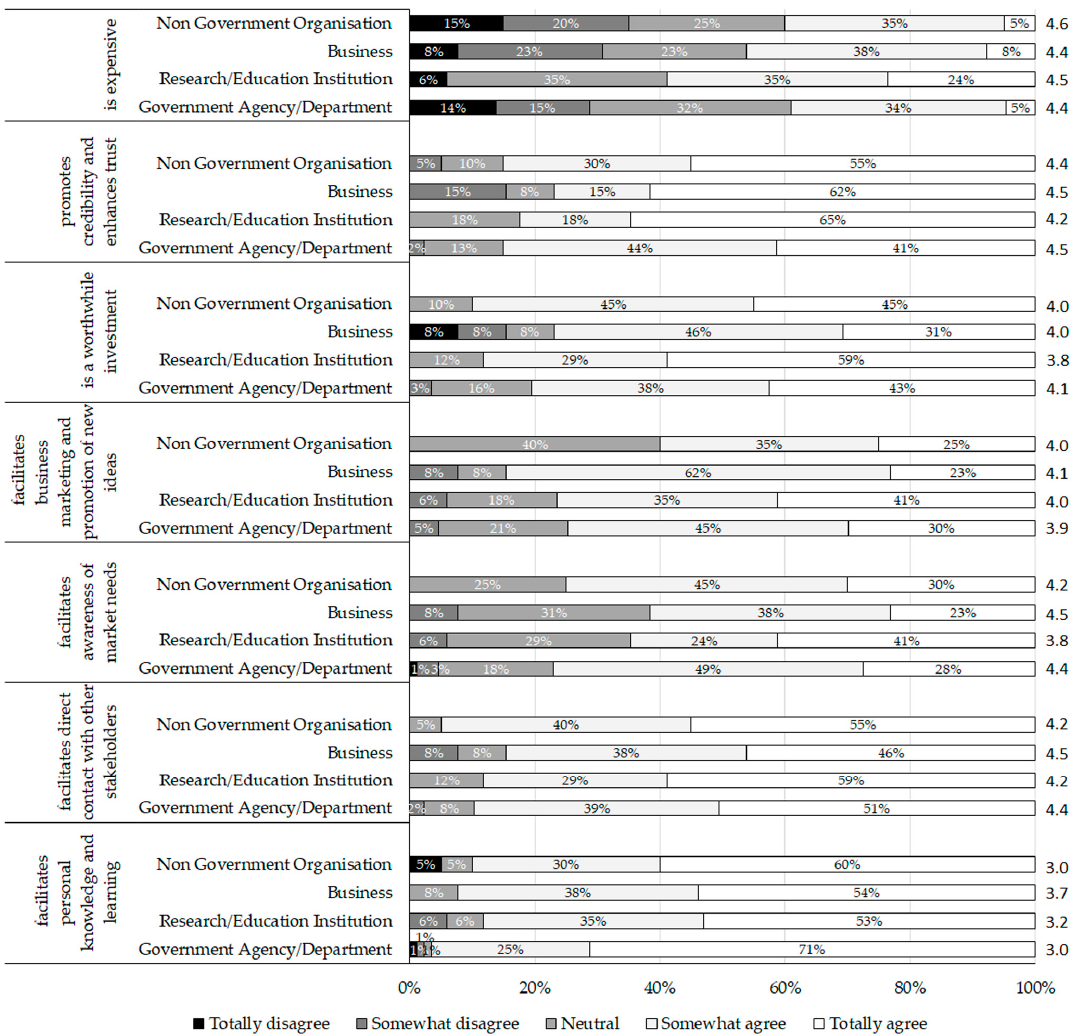
Figure 9. Perceived benefits for the different stakeholders of being part of a professional association. The percentages of selections for each level of agreement are reported in the bars. Mean values of agreement have been calculated by assigning 5 to Totally agree, 4 to Agree, 3 to Neutral, 2 to Disagree, and 1 to Totally disagree ( n = 137).